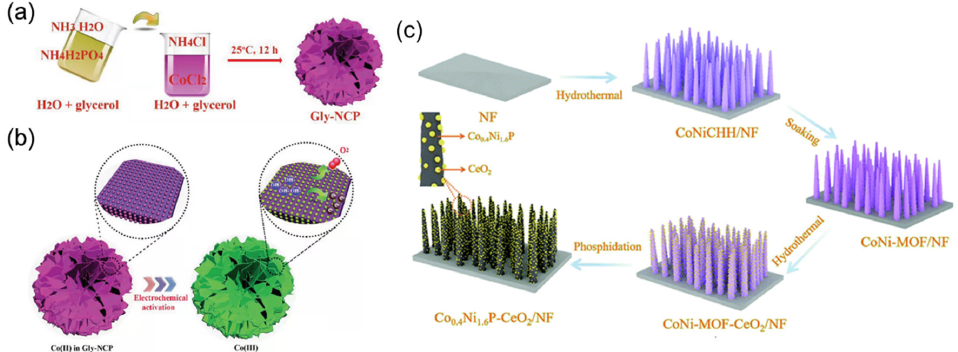
Figure 8. ( a ) The synthesis procedure of Gly-NCP nanosheets [48]; ( b ) the electrochemical activation process of Gly-NCP for improved OER activity [48]; ( c ) the schematic diagram for the preparation of Co 0 . 4 Ni 1 . 6 P-CeO 2 /NF [49].